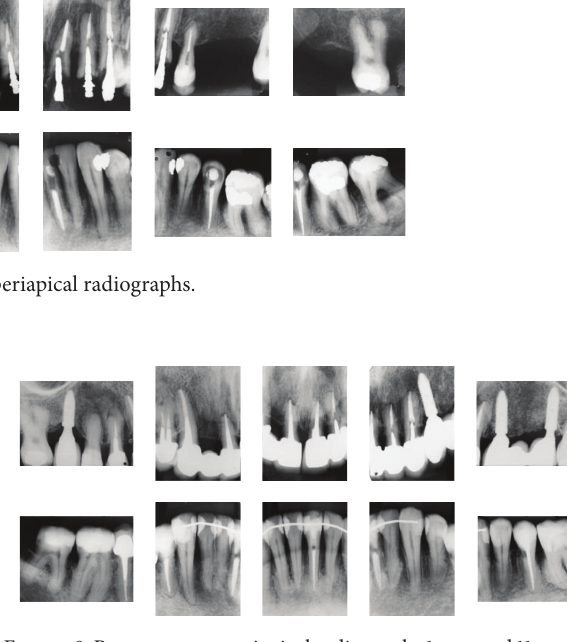
Figure 8: Posttreatment periapical radiographs 1 year and 11 months after